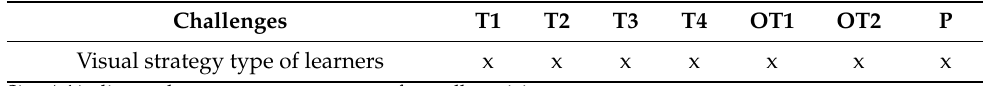
Table 6. Visual strategy type of